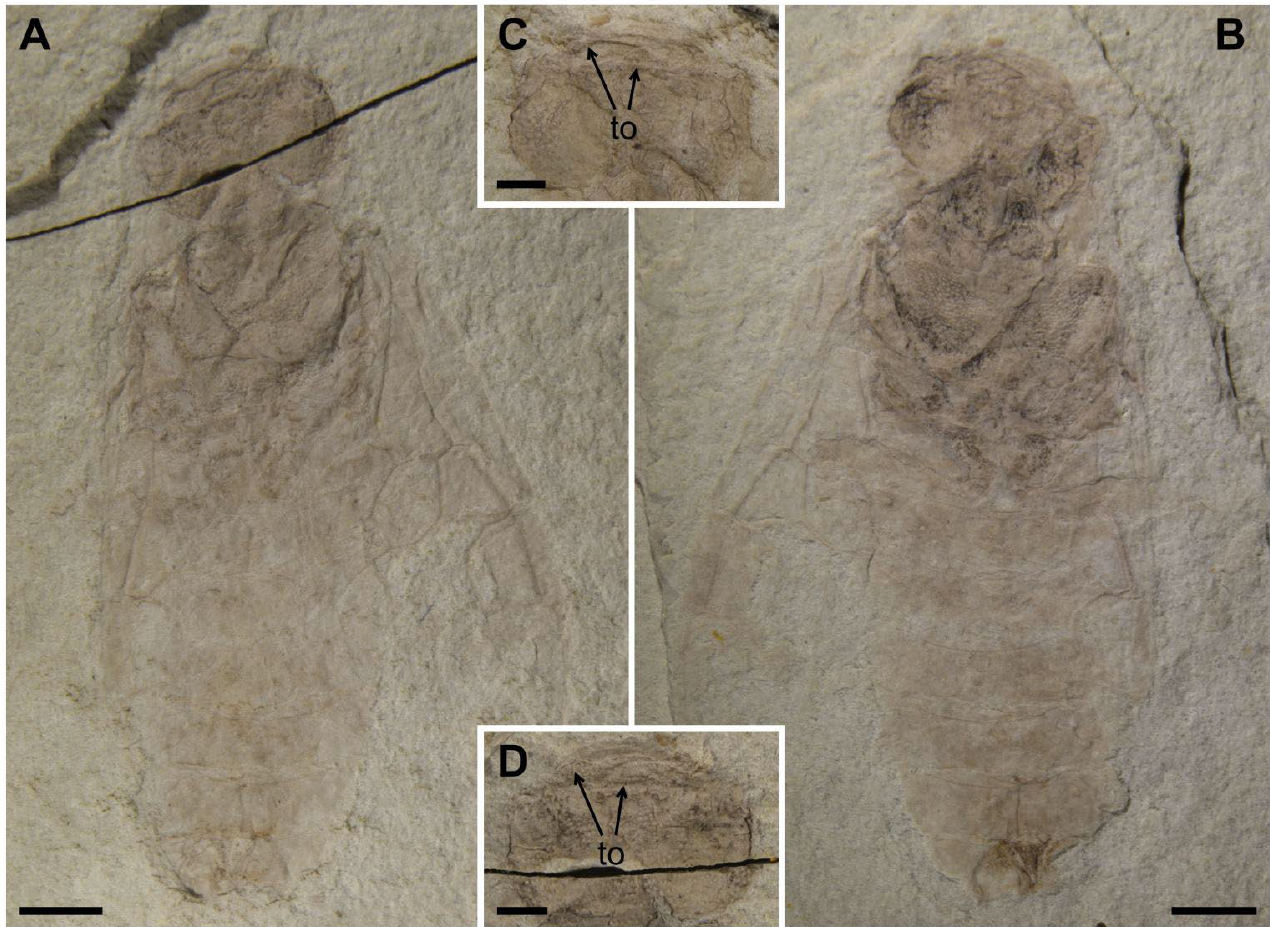
Figure 3. Scabolyda latusa sp. nov., Paratype (CNU-HYM-NN2022103p/c) female. ( A ) Dorsal view of body as preserved. ( B ) Ventral view of body as preserved. ( C ) Ventral view of head. ( D ) Dorsal view of head. Symbol: to = tooth. Scale bars: 2 mm in ( A , B ); 1 mm in ( C , D ). Locality and horizon. Jiulongshan Formation; Daohugou Village, Shantou Township,